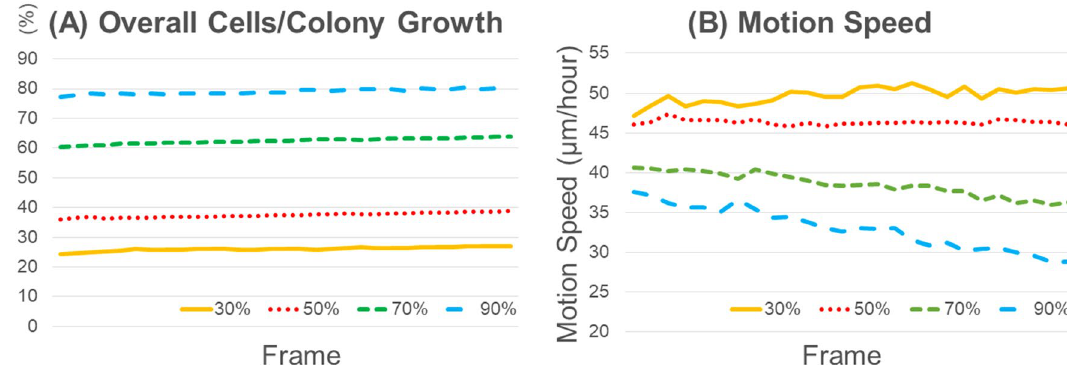
Figure 1. Characteristics of p1 oral keratinocyte cells/colonies growth in space and time. Representative overall cells/colony growth ( A ) and motion speed (MS) ( B ) for 4 h (31 frames) depending on four different initial cell confluencies under manual observation (30%, 50%, 70% and 90%). This data was used to determine what cell growth conditions were appropriate to start the time-lapse microphotography in this study. ( A ) Representative changes in overall cells/colony growth of p1 oral keratinocytes. The overall cells/colony growth was almost unchanged over time regardless of the initial cell confluency. ( B ) Representative changes of MS of p1 oral keratinocytes over time. MSs showed different patterns depending on the four different initial cell confluencies (30%, 50%, 70% and 90%).